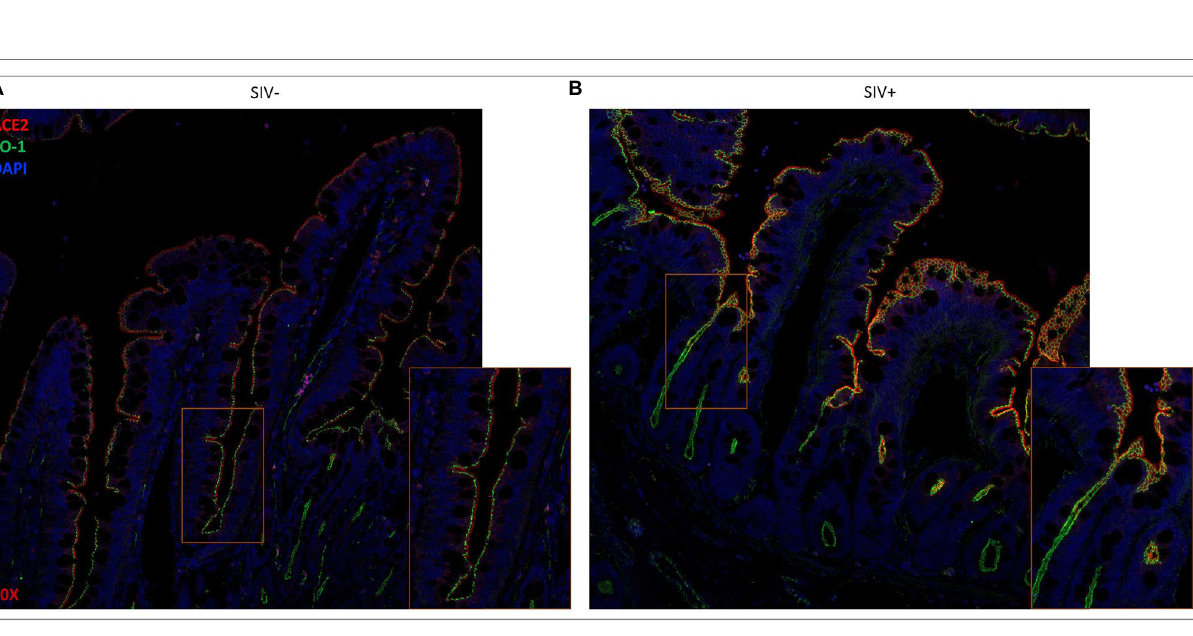
FIGURE 2 | ACE2 expression remains localized along the gut epithelium in SIV infected rhesus macaque. Representative images of (A) uninfected and (B) SIV infected ileum tissues after fluorescent staining showing co-localization of ACE2 (red) and ZO-1 (green) in extracellular linings of villus epithelium. Cellular DNA (DAPI) is shown in blue to display the nuclei. Magnification: